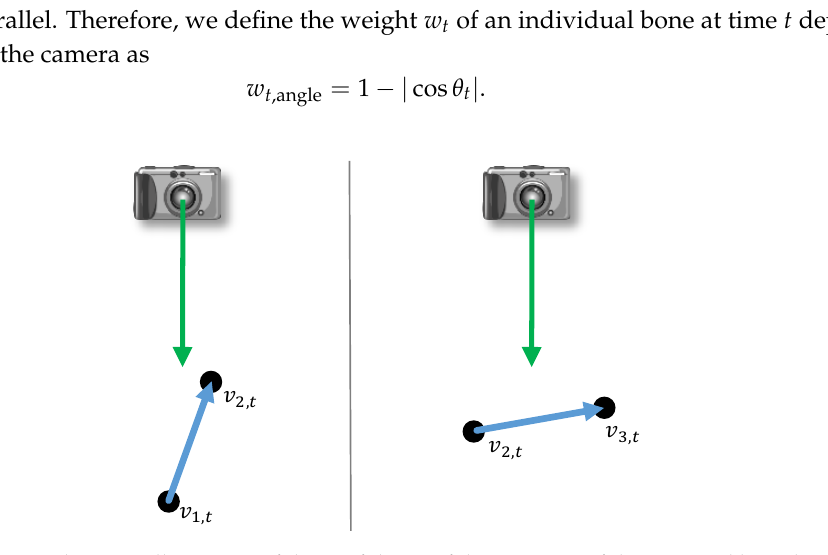
Figure 7. An exemplary 2-D illustration of the confidence of the accuracy of the captured bone lengths. We assume that an individual bone and its respectively connected joints are less accurately determined if the orientations of the bone and the optical axis of the camera are similar ( left ). In contrast, a higher accuracy is expected when the bone orientation is perpendicular to the camera orientation ( right